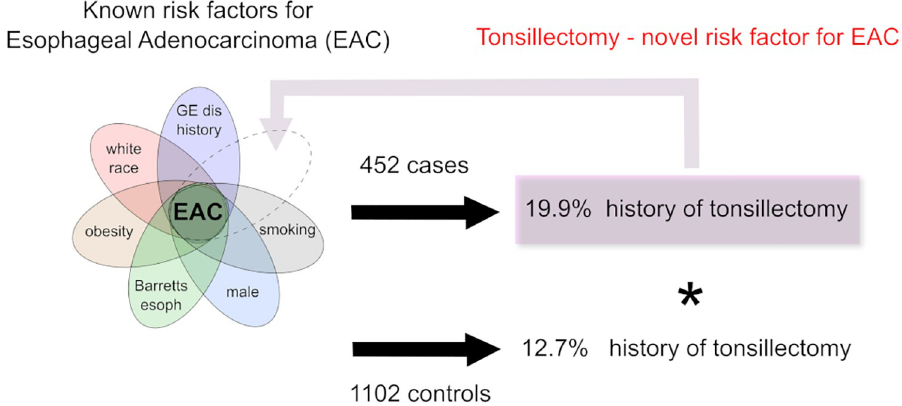
Fig 1. Illustration of our study showing the distribution of tonsillectomy in our cases and controls in relation to known risk factors for